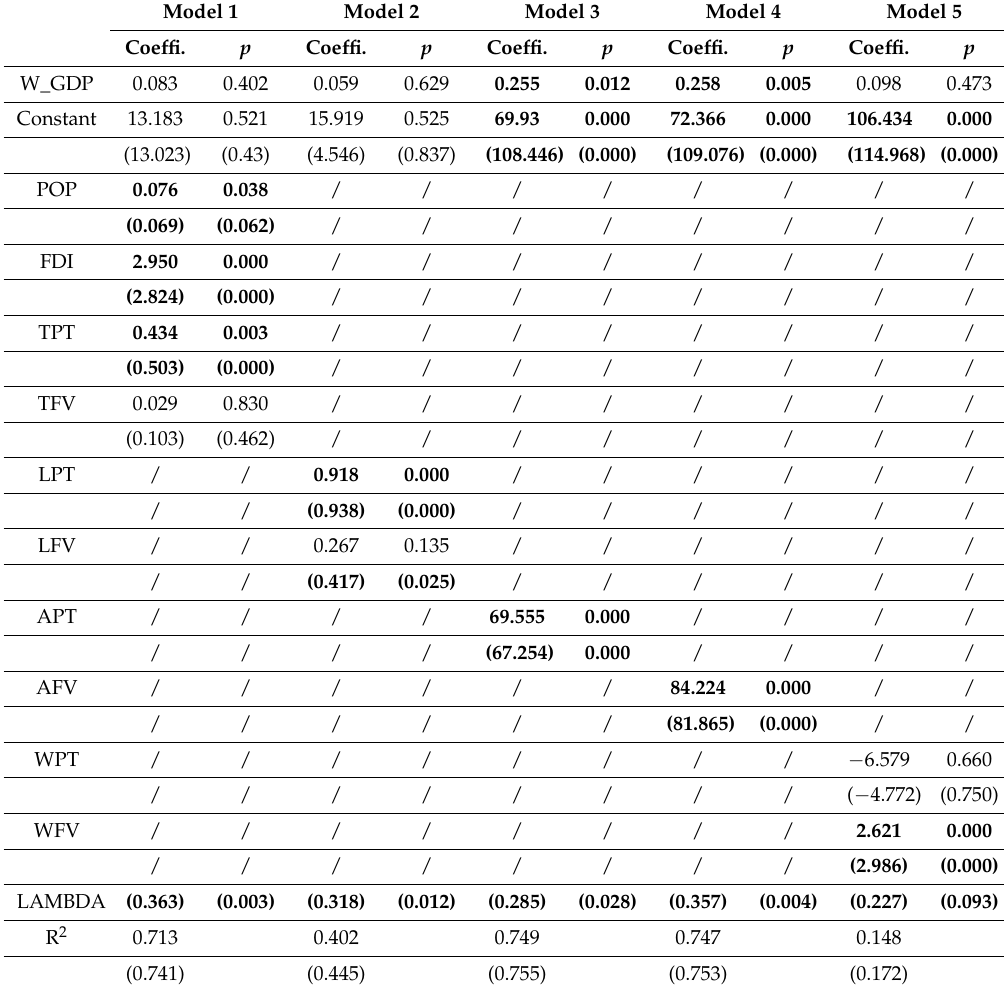
Table 7. SLM/SEM estimation results for the central